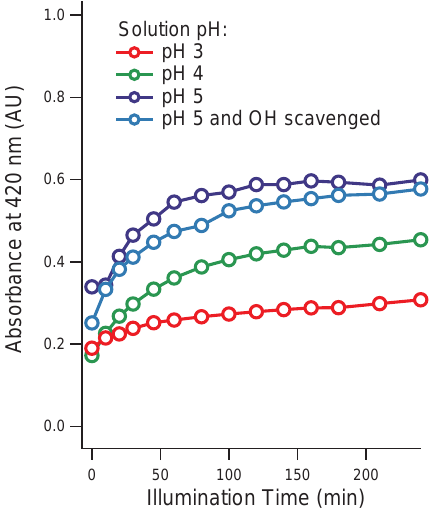
Figure 7. Time profiles of 4NC absorbance at 420nm during direct photolysis experiments. Experiments were performed at three solu- tion pH values. An OH scavenger experiment was also performed by adding 1mM glyoxal to the pH 5